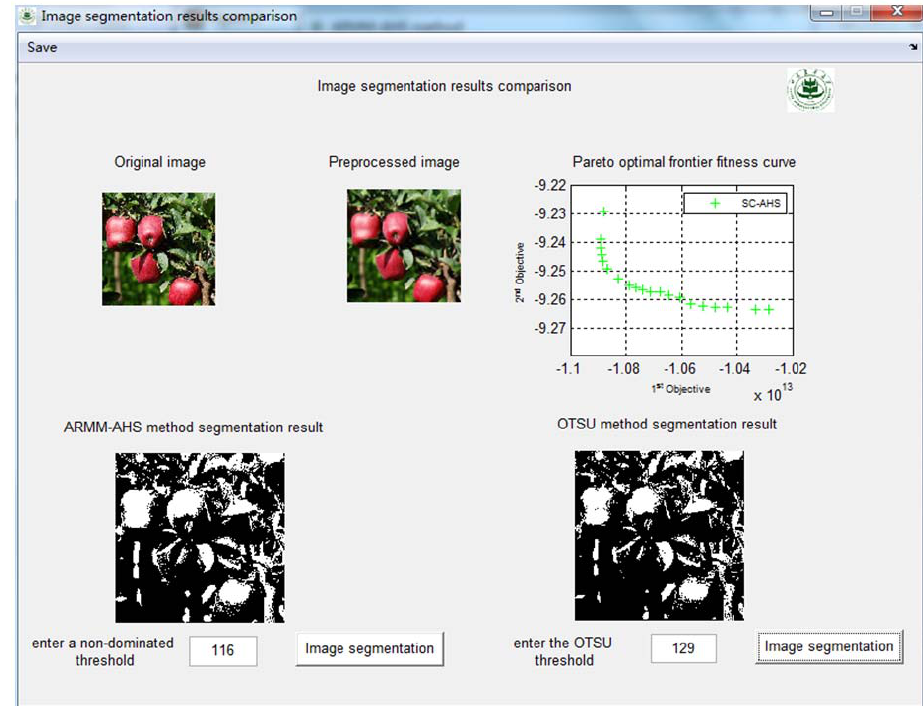
Figure 15. Comparison of the results of image segmentation under direct sunlight under the strong illumination condition.